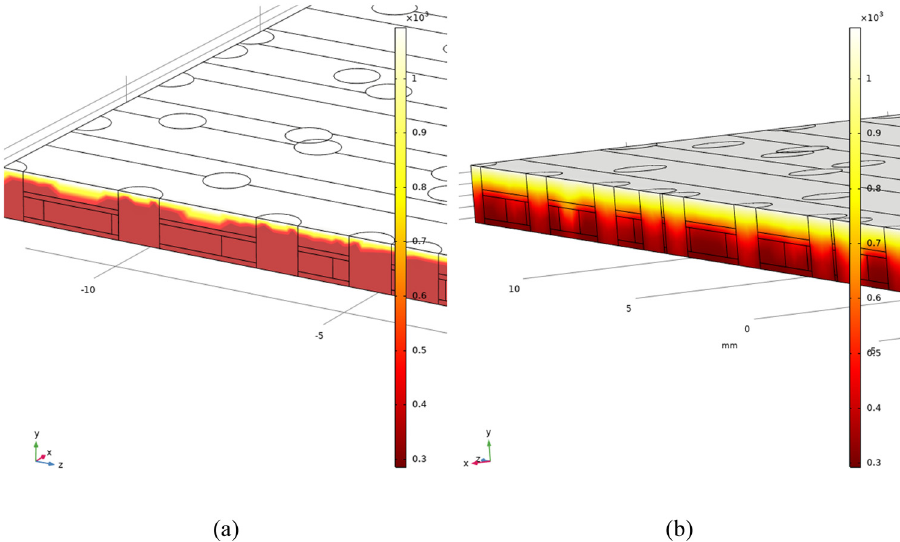
Figure 6: Simulation results for vertical heat conduction: ( a ) 5 s and ( b ) 10